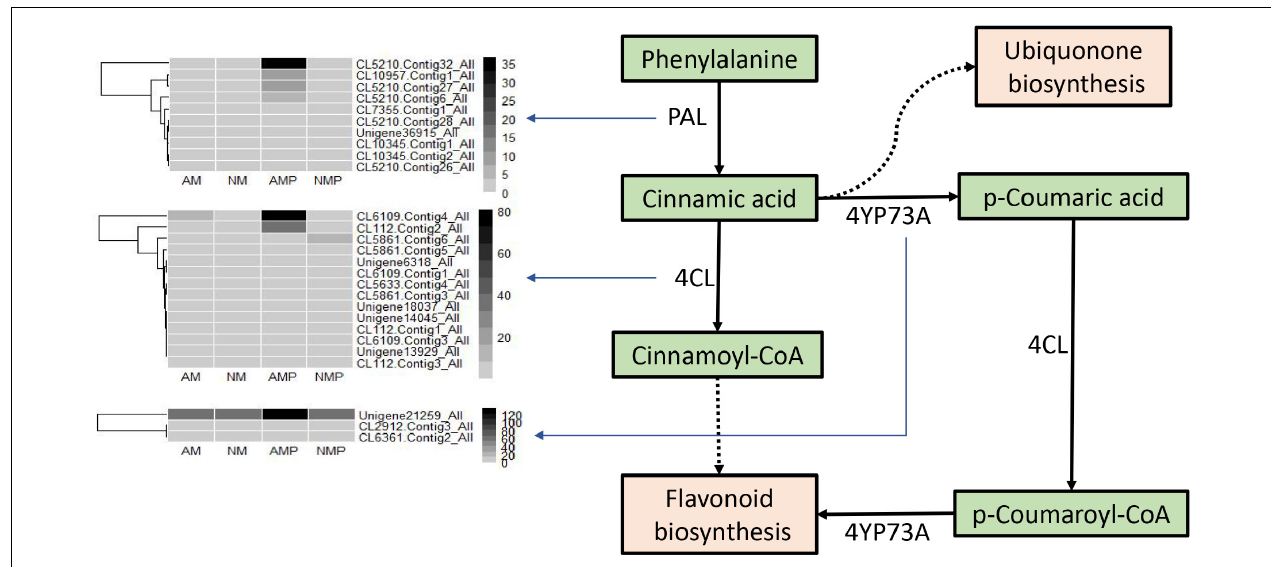
FIGURE 8 | Regulating genes expression and graphical overview of the phenylpropane biosynthesis. NM = uninoculated with S. tortuosa , AM = inoculated with S. tortuosa , NMP = NM inoculated with C. lentis , and AMP = AM inoculated with C. lentis